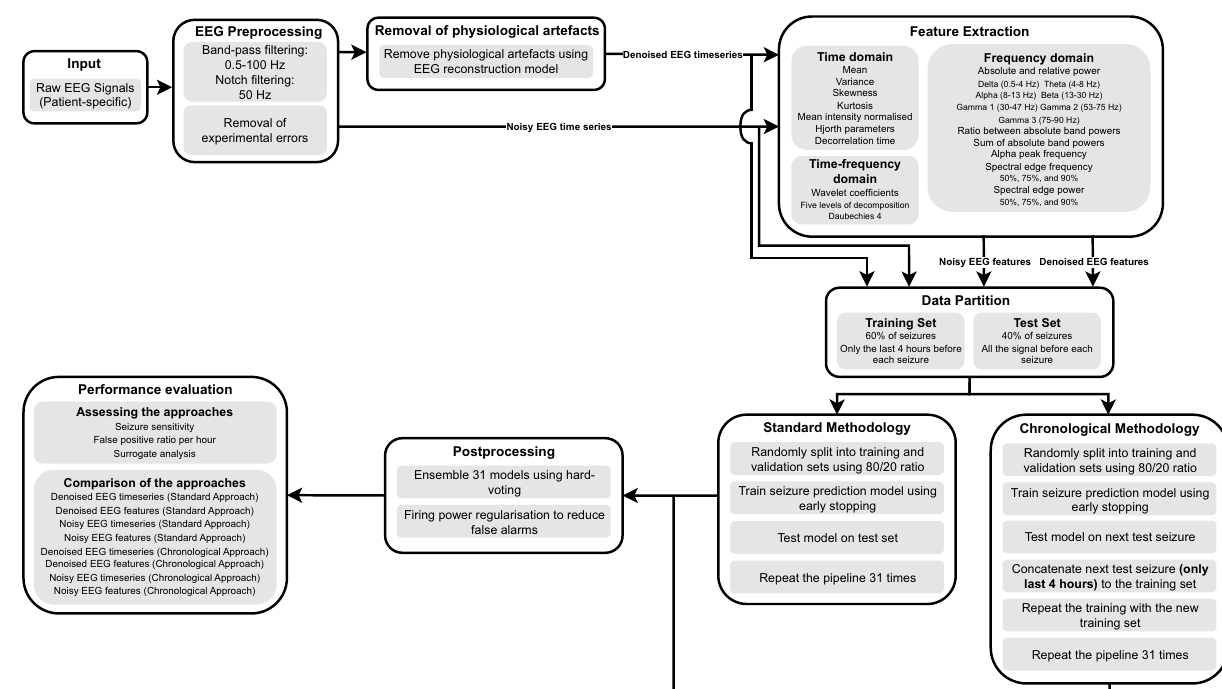
Figure 1. Seizure prediction pipeline comprising EEG preprocessing, feature extraction, data partition, training approaches, postprocessing, and evaluation procedure. All models were trained following a patient-specific approach. Therefore, this pipeline was repeated for each patient,